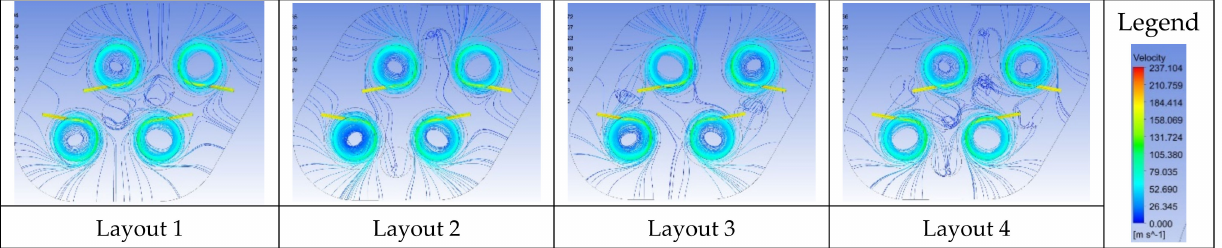
Figure 16. Streamline of quad-vortex array grippers with exhaust vents (configuration 2, L = 4/3 D 3 ).